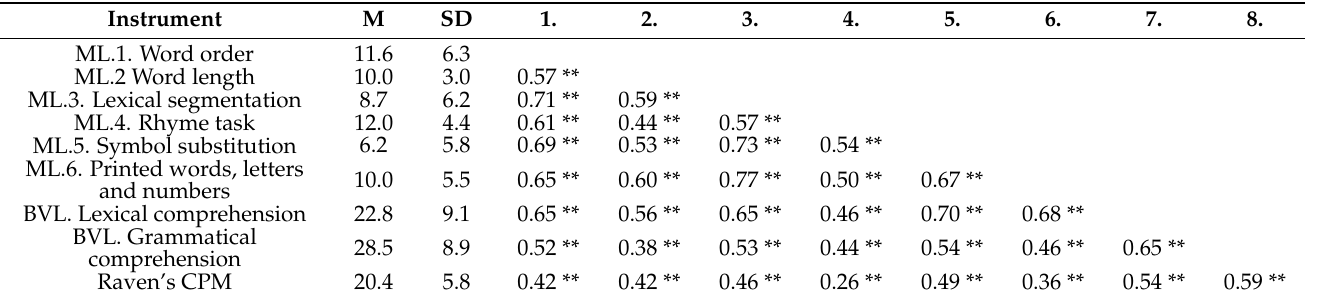
Figure 1. Age-group differences in metalinguistic abilities. Table 3. Descriptive statistics and